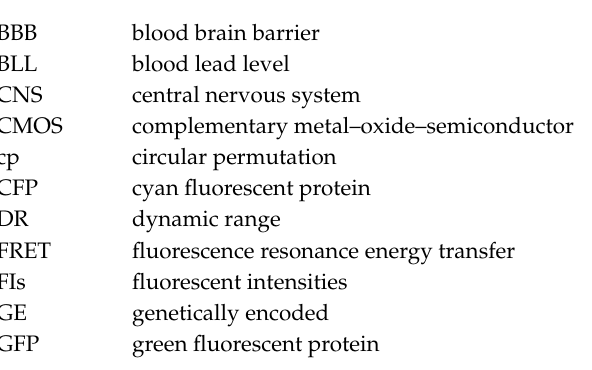
Figure S1: Expression pattern of GFP and Met-lead in adult Drosophila brains. Di ff erent types of neurons expressing GFP (upper part, Elav-gal4 > UAS-GFP ; R13F02-gal4 > UAS-GFP ; Cha-gal4 > UAS-GFP ) or expressing Met-lead (lower part, Elav-gal4 > Met-lead ; R13F02-gal4 > UAS-Met-lead ; Cha-gal4 > UAS-Met-lead ) were examined under a confocal microscope for 3D imaging. The scale bar is 50 µ m. Figure S2: Practical application of Met-lead to adult Drosophila brains at a lower magnification (4x, compared with Figure 4 at 20x). (a) The in vivo biosensing of lead in Drosophila ( Cha-gal4 > UAS-Met-lead ) was carried out using an upright FRET imaging platform. During a 30-s recording, a bu ff er containing lead ions (10 µ M) and ionomycin (5 µ M) was added. Representative images of fly brains (cholinergic neurons) in the YFP channel (12 graphs numbered with the time points in minutes, upper), in the CFP channel (middle), and in a ratio (YFP / CFP, YC bottom) are shown. The rainbow color images were combined through a ratio imaging process. (b) and (c) The time-lapse plots from selected regions are displayed as fluorescent intensities (FIs) (YFP in red lines and CFP in blue lines (b) and emission ratios (c)). In (a), the scale bar is 50 µ m and the rainbow color ratio bar is 1–3. Figure S3: YC montage images of Met-lead within the larval CNS of Drosophila. Control (upper) and lead-containing (lower) CNSs are shown in di ff erent optical sections in an RG merged manner or in a ratio color manner (the ratio color bar runs from –0.5 to 2.8). Supplementary Video S1: Biosensing of intracellular lead ions by Met-lead through a stereo microscope (Case 1). Supplementary Video S2: Biosensing of intracellular lead ions by Met-lead through a stereo microscope (Case2). Supplementary Video S3: Ratio color images of the control larval CNS in each optical section. Supplementary Video S4: Ratio color images of the Pb-treated larval CNS in each optical section. Supplementary Video S5: YC merged images of the control larval CNS in a 3D stack rotated on one axis. Supplementary Video S6: YC merged images of the control larval CNS in a 3D stack rotated on another axis. Supplementary Video S7: YC merged images of the Pb-treated larval CNS in a 3D stack rotated in one axis. Supplementary Video S8: YC merged images of the Pb-treated larval CNS in a 3D stack rotated on another axis. Supplementary Video S9: YC merged images of the control larval CNS ex vivo in a 3D stack rotated on one axis. Supplementary Video S10: YC merged images of the control larval CNS ex vivo in a 3D stack rotated on another